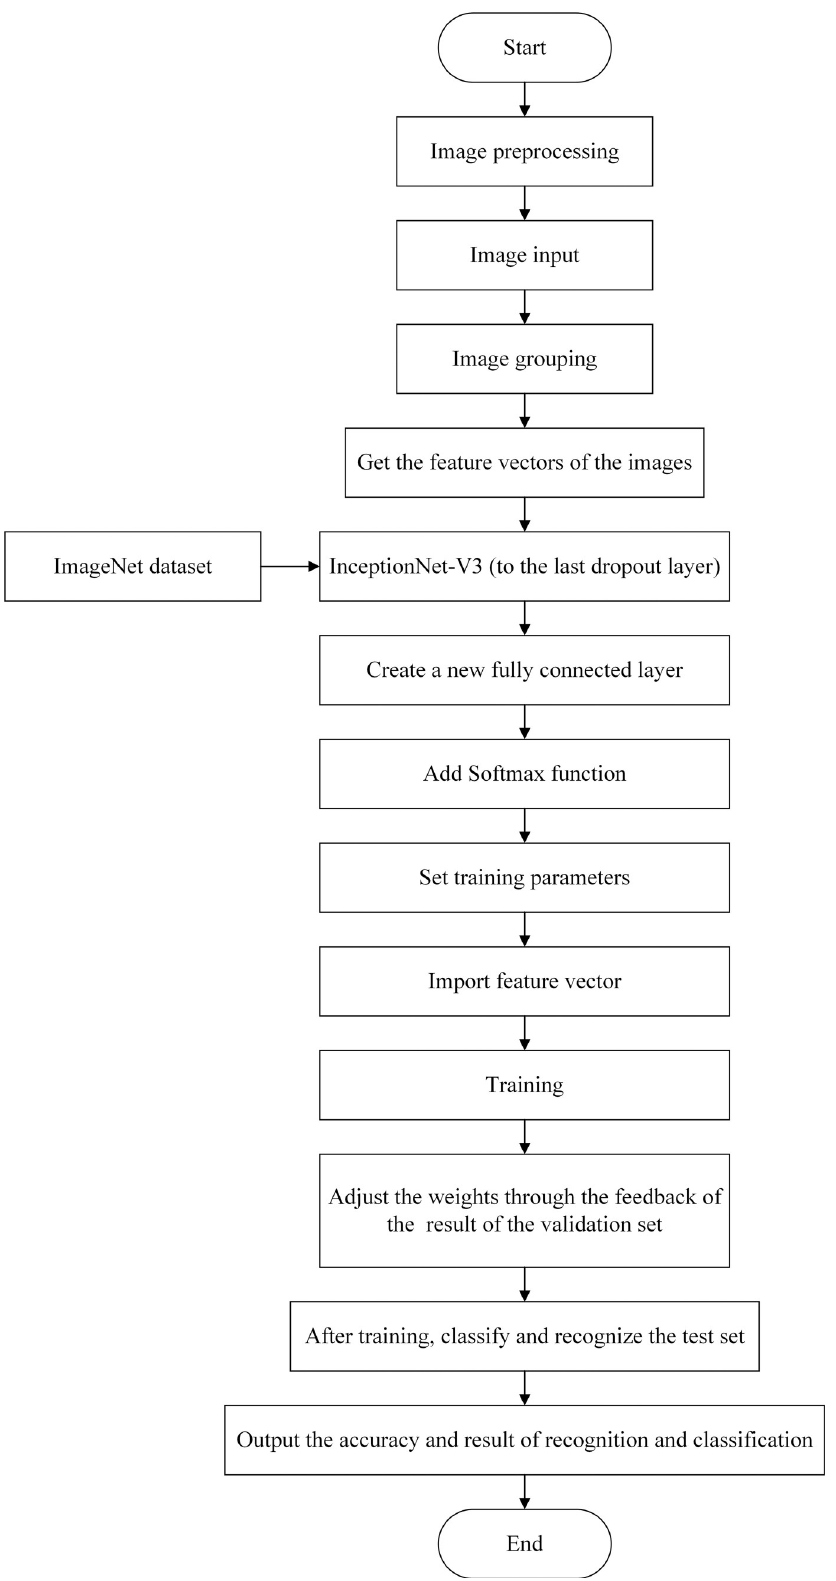
Fig 2. Modified flowchart of recognition of industrial machine